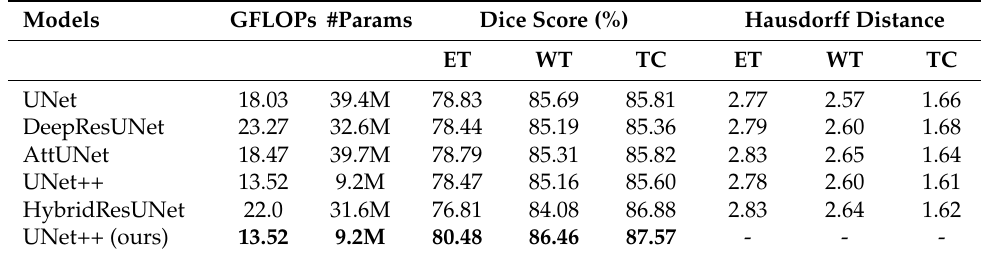
Table 2. Comparison with current popular methods.